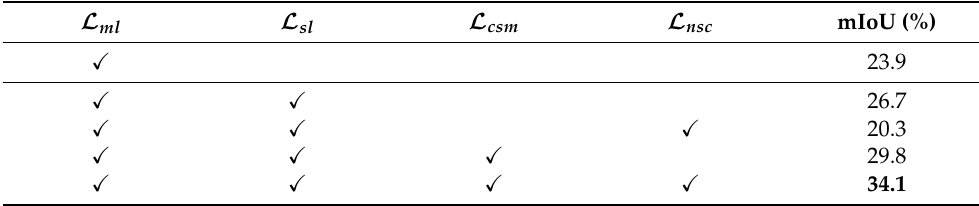
Table 8. The ablation research of different combinations of loss functions. We added L csm , L nsc , and L sl in turn to observe the quality of the CAMs on the iSAID dataset by combining different loss functions. The mIoU (%) is the evaluation metric for CAM quality. L L ml